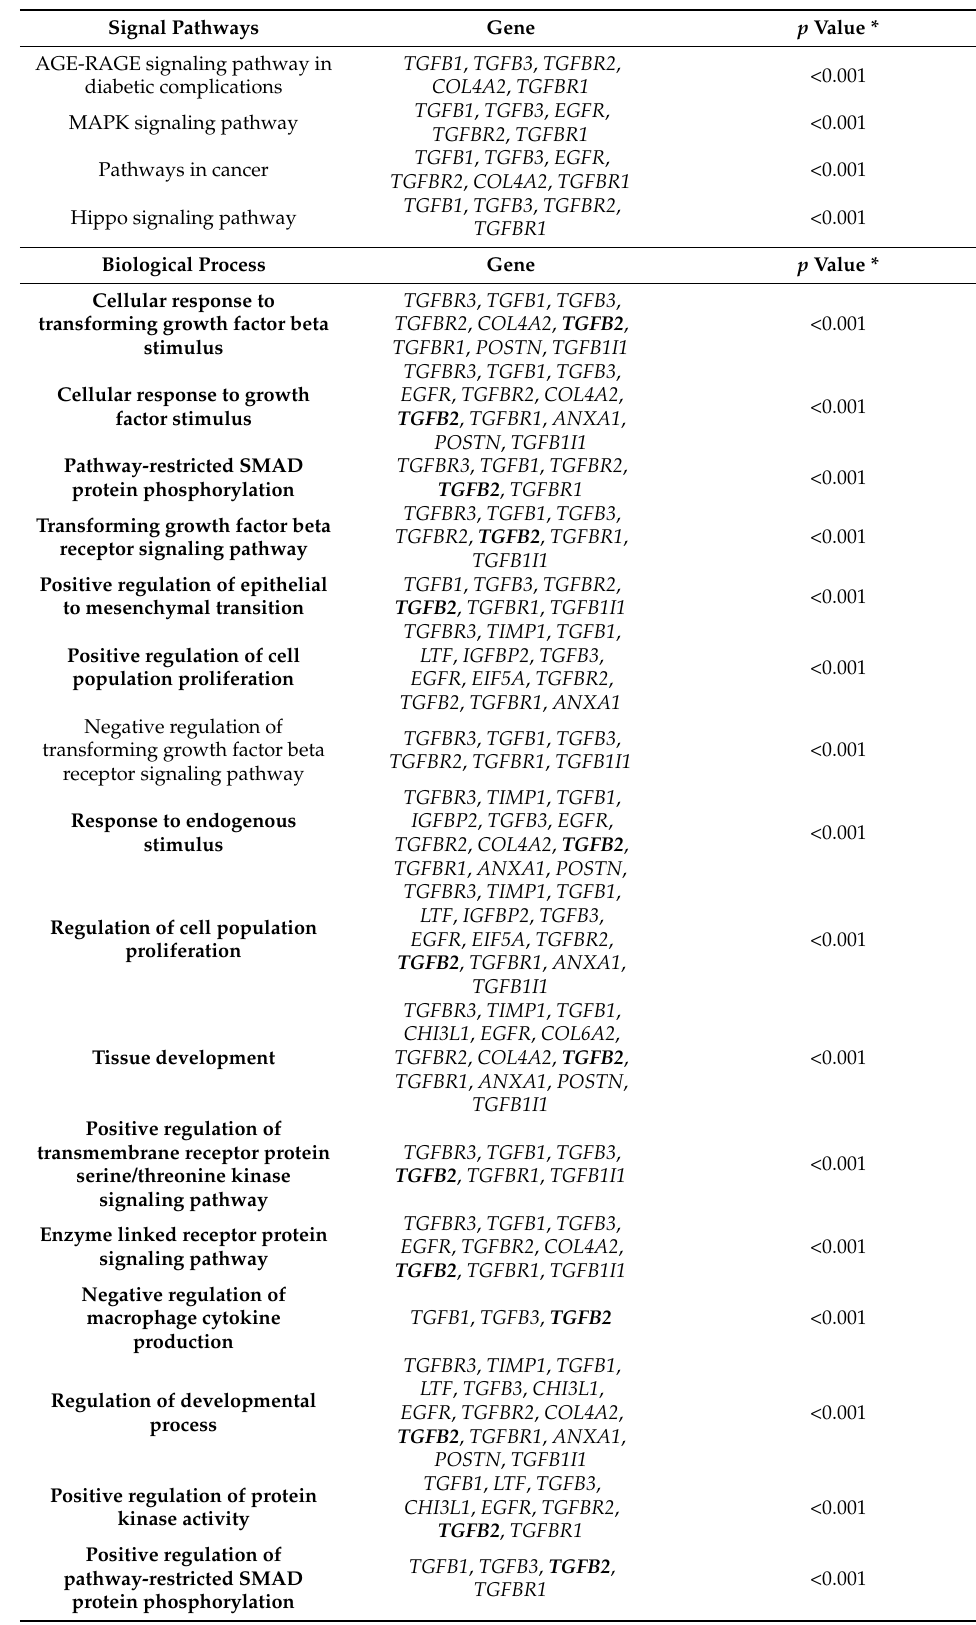
Table 5. Cont. Signal